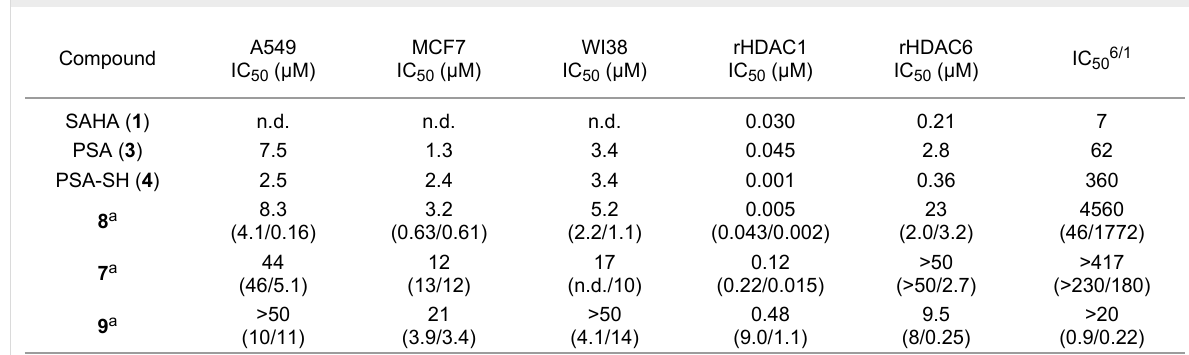
Table 1: Biological